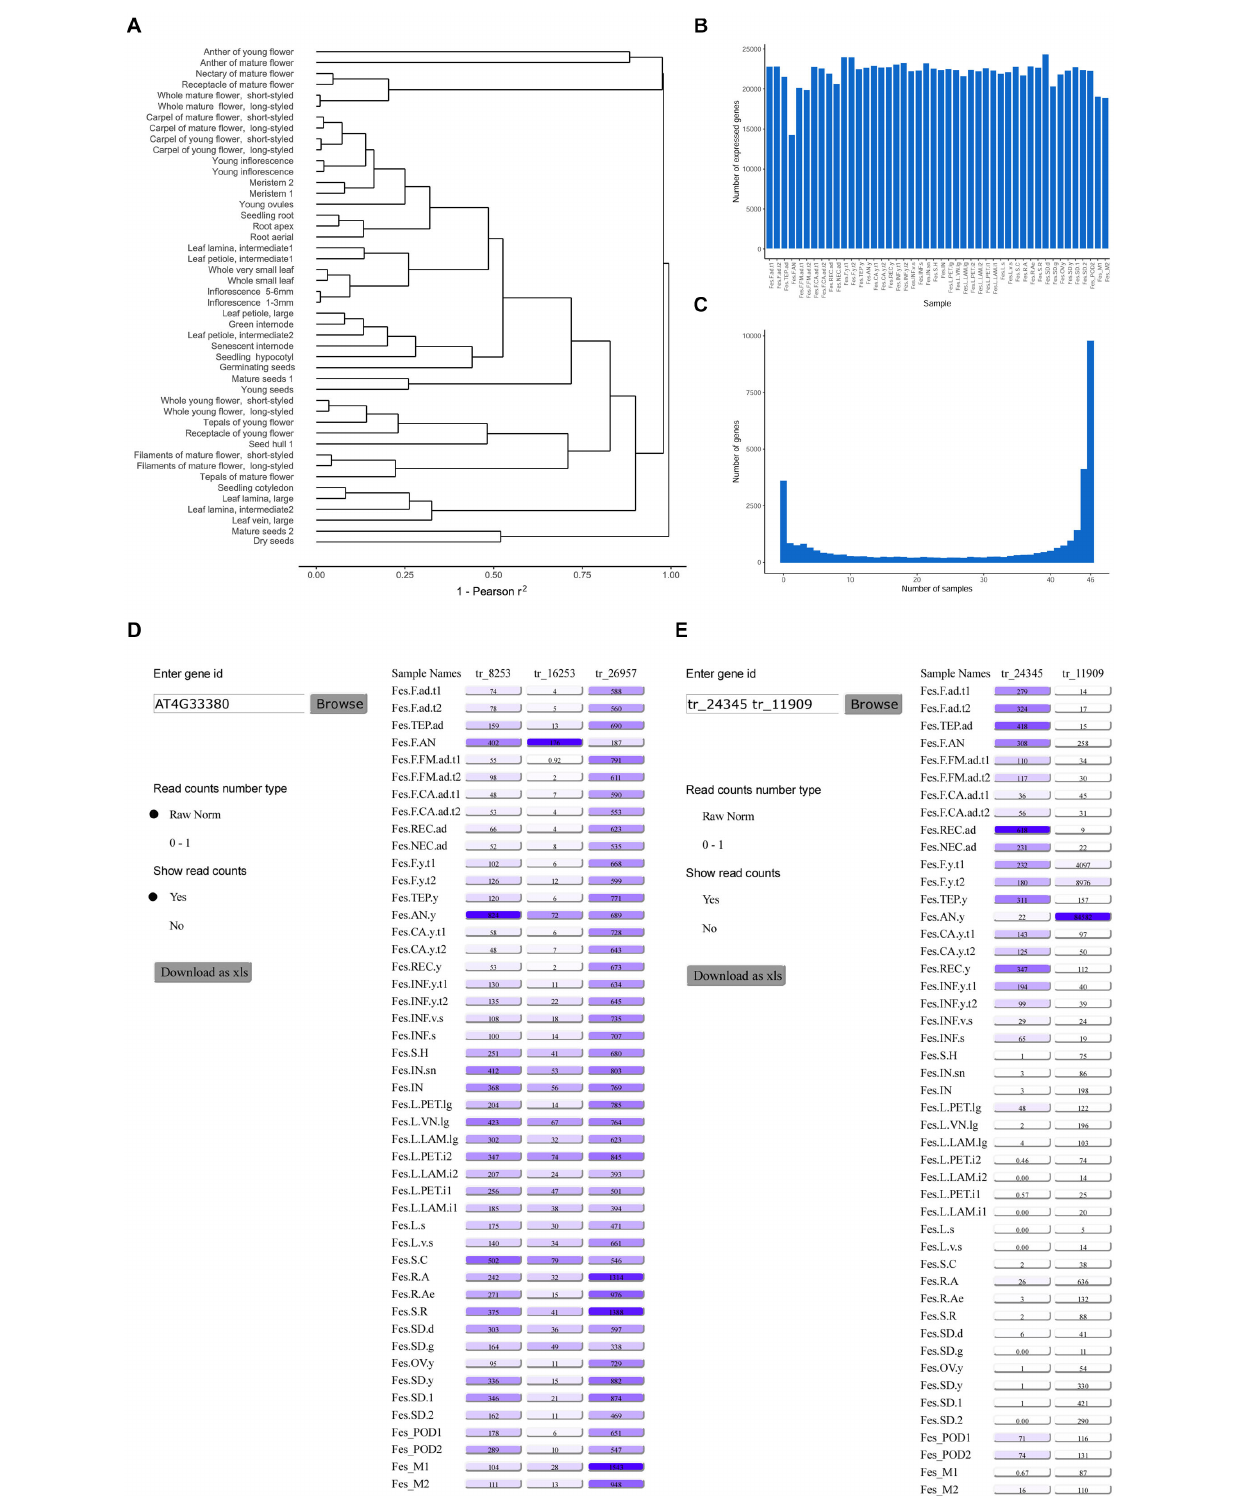
Frontiers in Plant Science |